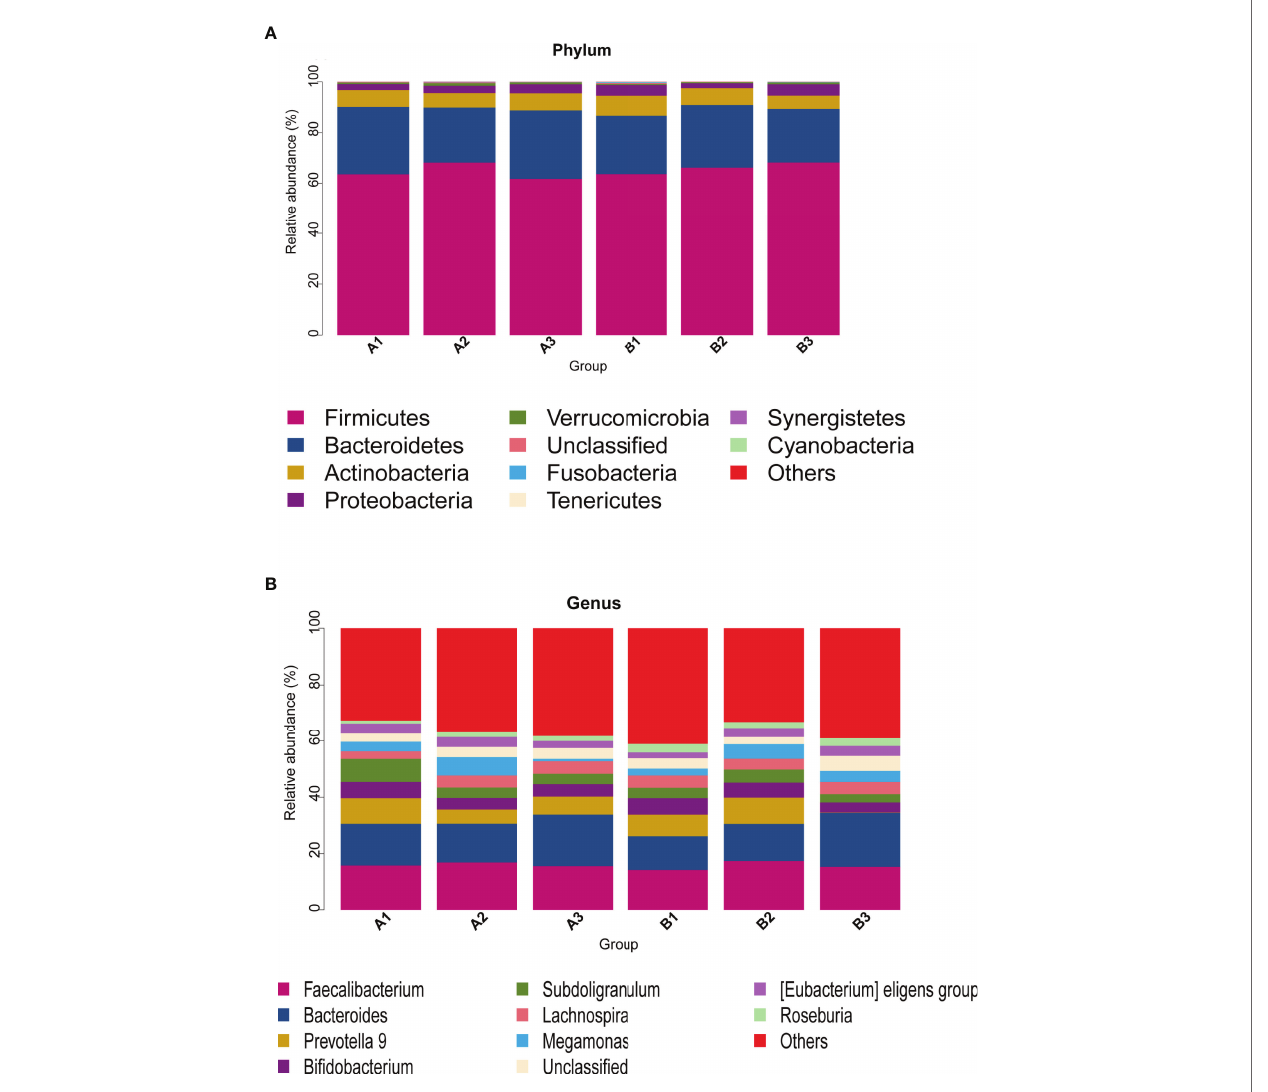
FIGURE 1 | (A, B) Taxonomic analysis at the phylum or genus level. A1, TPOAb-positive women with SCH and no LT 4 ; A2, TPOAb-positive women with SCH and low-dose LT 4 ; A3, TPOAb-positive women with SCH and high-dose LT 4 ; B1, TPOAb-negative women with SCH and no LT 4 ; B2, TPOAb-negative women with SCH and low-dose LT 4 ; B3, TPOAb-negative women with SCH and high-dose LT 4